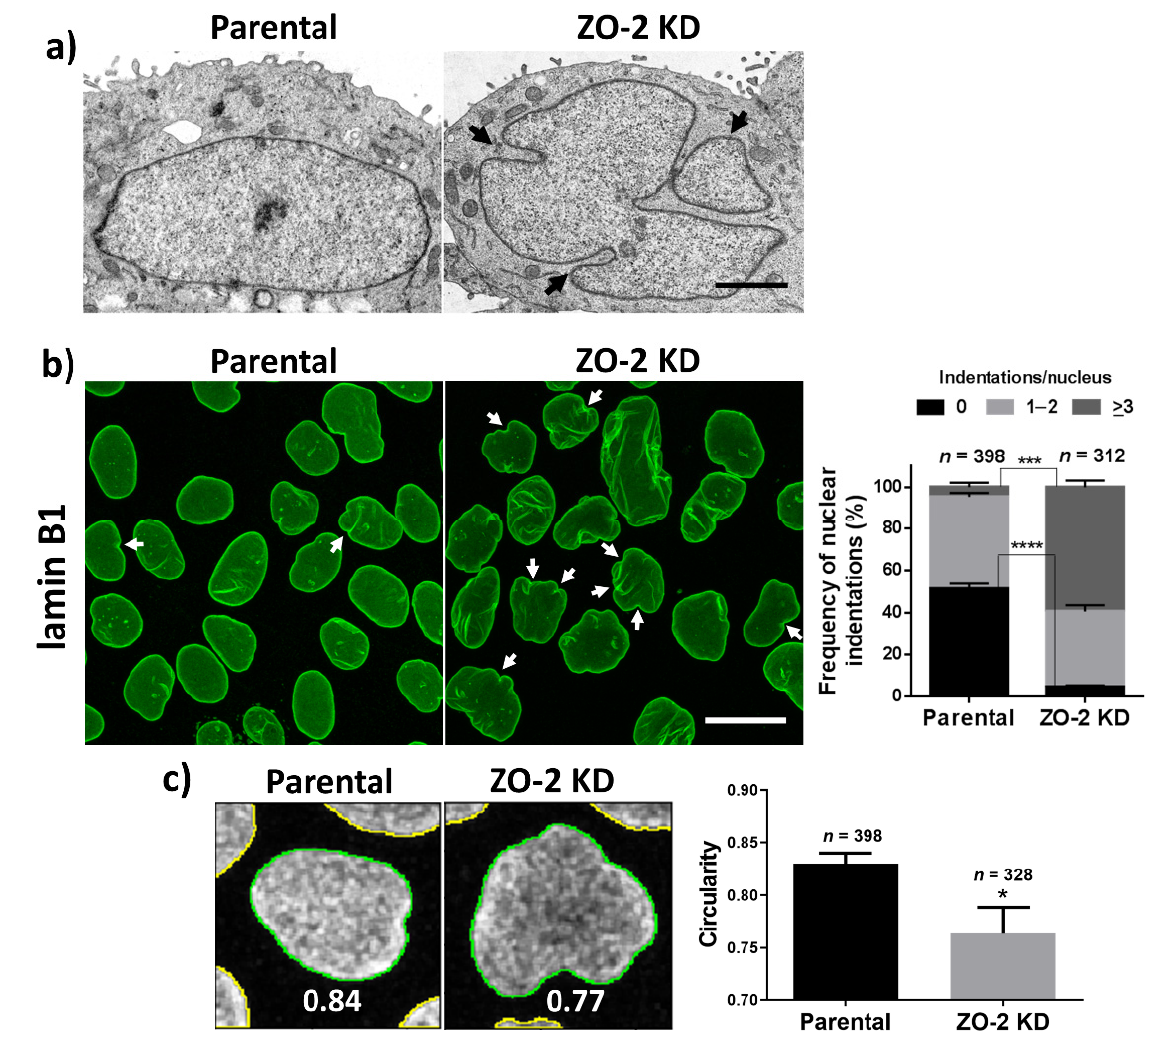
Figure 1. The nuclei of ZO-2 KD MDCK cells are lobulated and have multiple indentations. ( a ) Transmission electron microscopy of parental and ZO-2 KD MDCK cells. Arrows, nuclear lobulations. Bar, 20 µ m. ( b ) Immunofluorescence of parental and ZO-2 KD MDCK cells treated with an antibody against lamin B1. Left panel, a representative image of one optical section per experimental condition; arrows, nuclear indentations. Bar, 20 µ m. Right panel, quantitative analysis. Statistical analysis was done with Student’s t -test. Results shown as media ± standard deviation *** p = 0.001; **** p < 0.0001. ( c ) Quantification of nuclear circularity. Left panel, a representative image of quantification of nuclear circularity in parental and ZO-2 KD MDCK cells stained with lamin B1. Right panel, results obtained from three independent experiments. n , number of nuclei evaluated. Statistical analysis was done with Student’s t -test. Results are shown as media ± standard deviation * p = 0.0130.